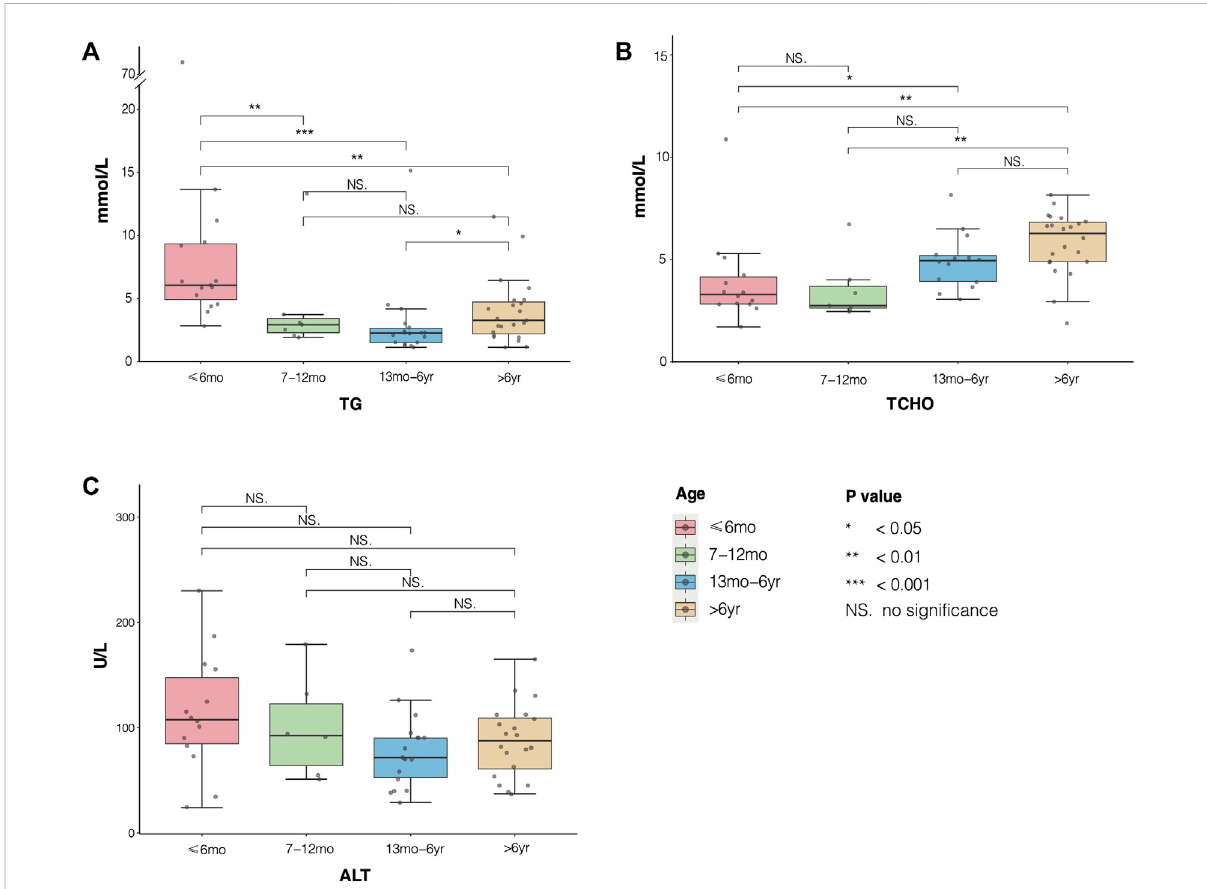
FIGURE 3 Distribution of serum triglyceride (TG), TCHO, and alanine aminotransferase (ALT) in different age groups of patients with transient infantile hypertriglyceridemia (HTGTI). The boxplots showed median and interquartile level valuesof TC, TCHO, and ALT in the four age groups. (A) statistical differences in TG were shown in group ≤ 6months compared with the other three groups, and group 13 months to 6 years with group > 6 years ( P < 0.05). (B) signi fi cant differences in TCHO were observed in group ≤ 6 months compared with group 13 months to 6 years and group > 6 years, and group 7 – 12 months with group 6 years (all P < 0.05). (C) there were no signi fi cant differences in serum ALT among thefour groups (all P >